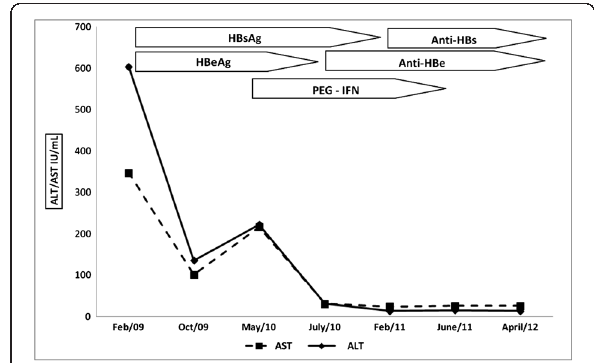
Figure 1 Evolution of biochemical and serological tests before and after